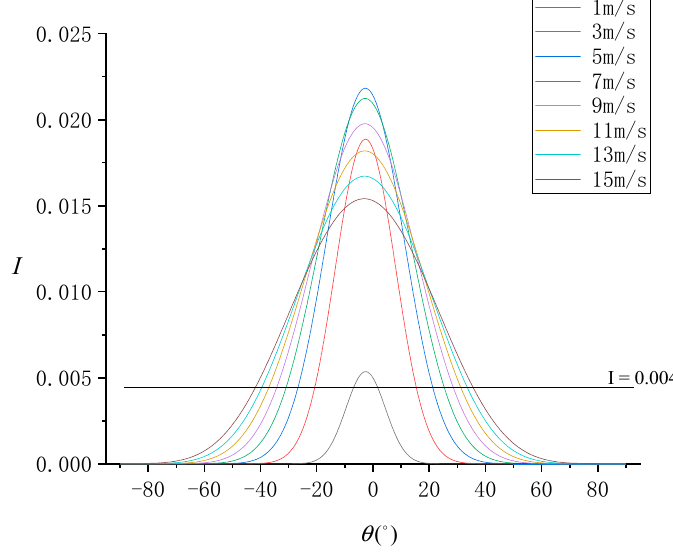
Figure 6. Normalized SG radiance ( (cid:1835) ) simulated under each SVA ( (cid:2016) ) at different wind speeds.